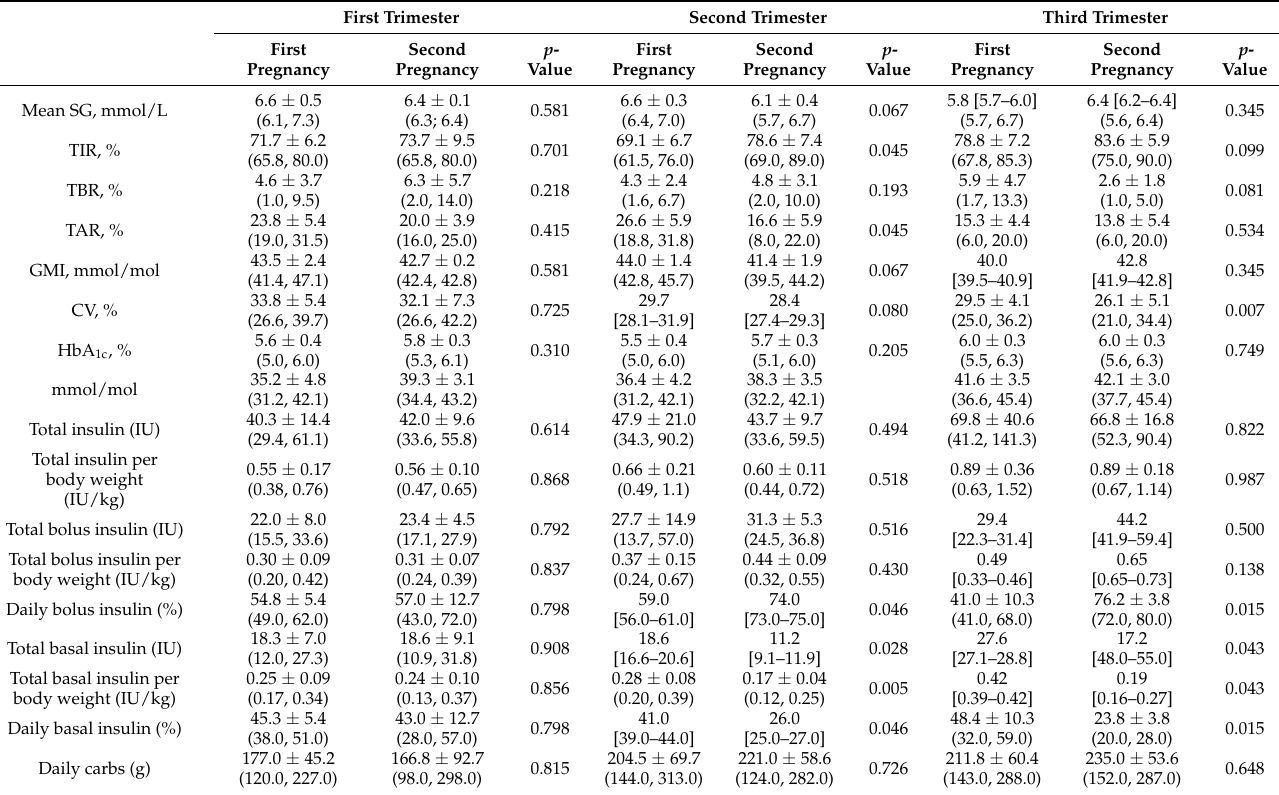
Table 2. Comparison of glycemic parameters between the first and the second